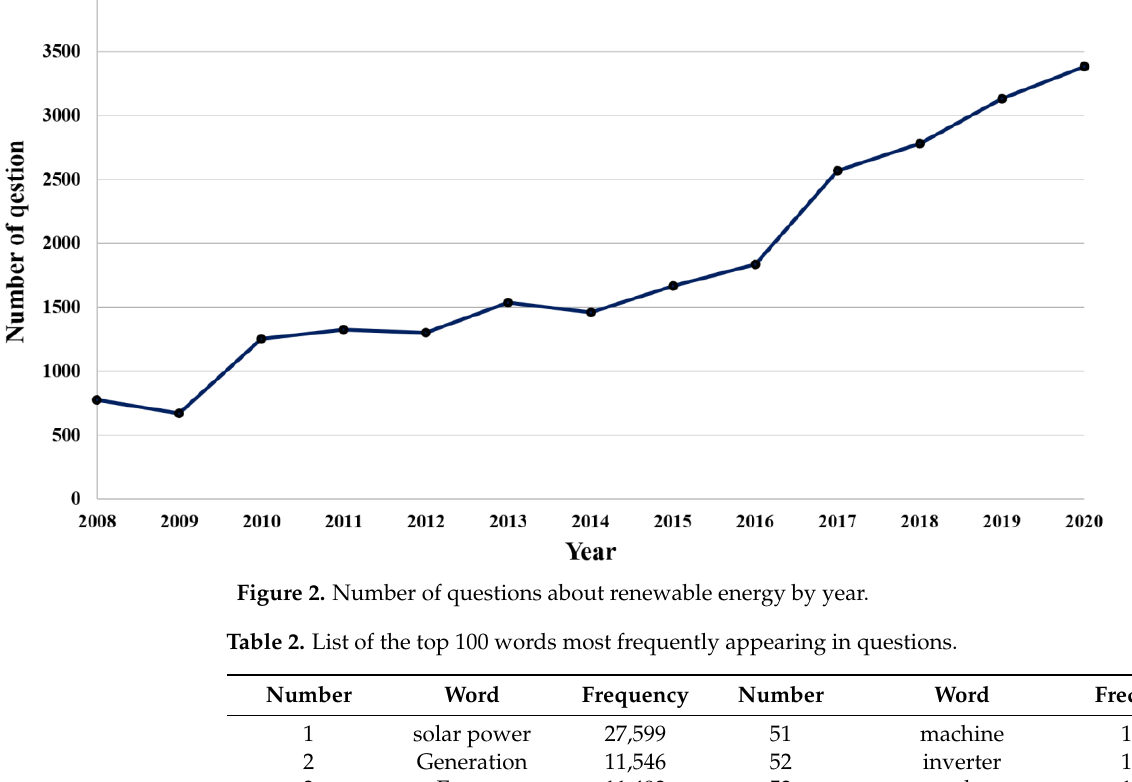
Table 2. List of the top 100 words most frequently appearing in questions.